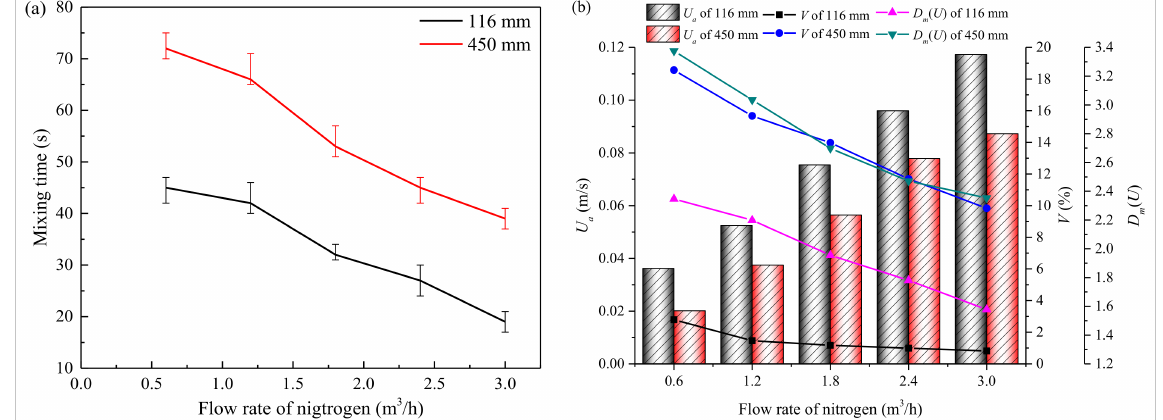
Figure 15. Mixing time and flow parameters of water in model ladle with four side plugs at different heights: ( a ) mixing time; ( b ) flow parameters of water.